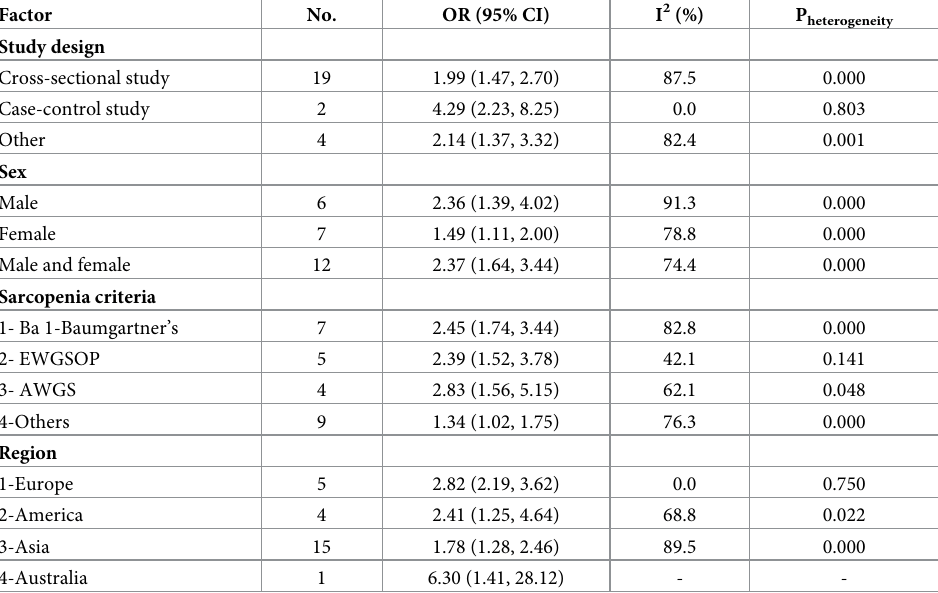
OR: estimate of the risk; CI: 95% confidence interval; No.: number of the included